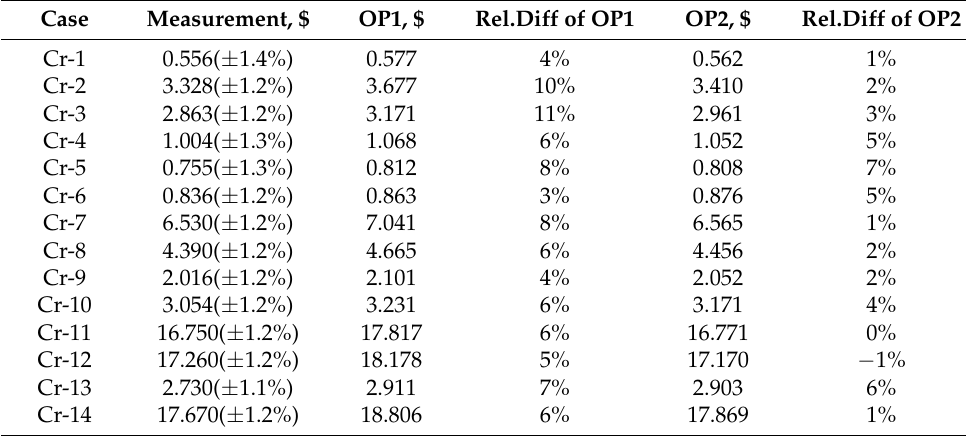
Table 4. Results and comparison of CRW value of ZPPR-9.